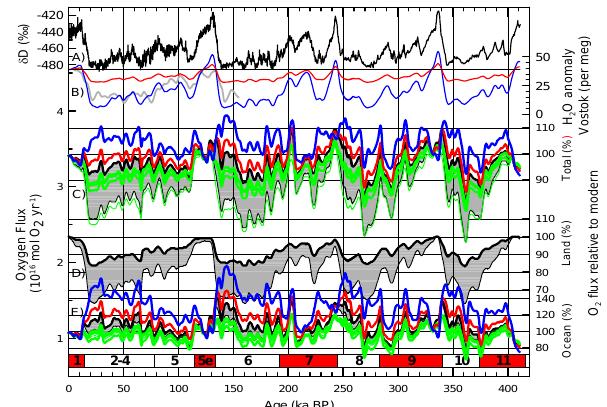
Fig. 4. (A) δ D record from Vostok (Petit et al., 1999). (B) Gray solid line is the smoothed record of the 17 1 anomaly in Vostok ice (Landais et al., 2008). Black, red, and blue solid lines are cal- culated anomalies for glacial values lower by zero, 10, and 30 per meg (see text for details). (C) , (D) , and (E) Total (plot C ), land (D) , and ocean (E) productivities relative to modern, calculated for vari- ous conditions. The black lines for land productivity are calculated from the CO 2 concentration derived after the empirical findings in Joos et al. (2004) for a C4 contribution of 40% (heavy black line) and 70% (light black line), respectively. Heavy black, red, and blue lines for ocean and total productivities are calculated for 40% C4 partition and relative to modern unchanged and 10 and 30 per meg lower glacial anomalies, respectively. Black light lines are calcu- lated in the same way for unchanged glacial anomalies and 70% C4 partitions. For better readability the solutions for 10 and 30 per meg lower glacial anomalies and 70% C4 partitions are not shown. They lie proportionally lower relative to their respective 40% C4 solutions, similar to the solutions for the unchanged case. All cal- culations except for the ones in green were made with a modern ocean water to atmosphere implementation of 173 per meg. The green lines show similar calculations but with a present ocean water vs. atmosphere value of 223 per meg. The spread of the green lines cover precipitation water anomalies 0 to 10 per meg lower than to- day, with and without photosynthetic fractionation of the ocean and C4 partitions of